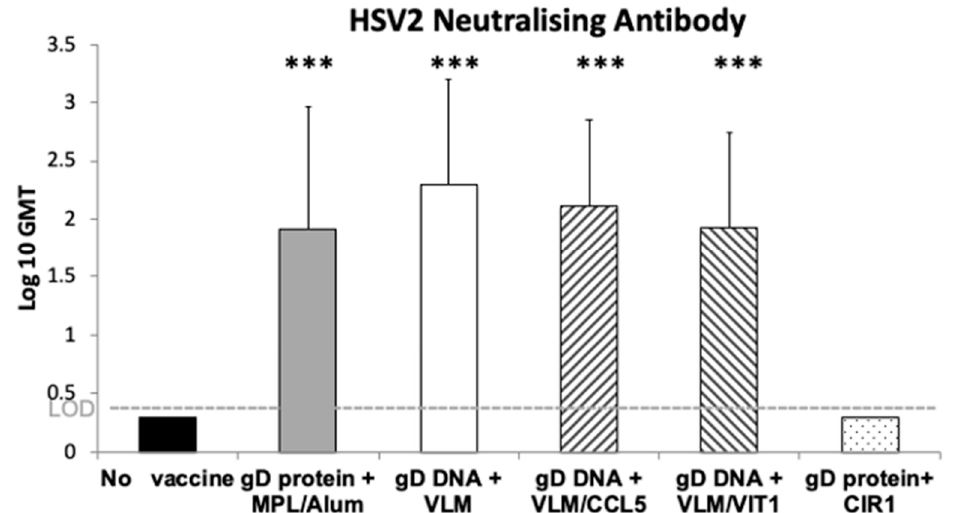
Figure 2. Antibody induction with VLM and VIT genes in guinea pig model. The guinea pigs, 12 per group, were immunised with saline or with the VLM gene formulations on their own or with chemokine CCL5 or VIT compared to positive control gD protein with MPL,3-O-desacyl-4’-monophosphoryl lipid A, with alum adjuvant or gD protein. An additional control immunisation included gD protein with cytokine immune regulator, CIR, human chemokine formulations, agonists with the same chemokine receptor specificity as VIT antagonist, as described in the methods. Guinea pigs were immunised intra muscularly two times separated by three weeks, then sera collected three weeks after the final immunisation. Virus neutralisation assays were conducted and mean end point titers are shown with standard deviation analysed by one way ANOVA with Tukey’s test for multiple comparisons, p < 0.001